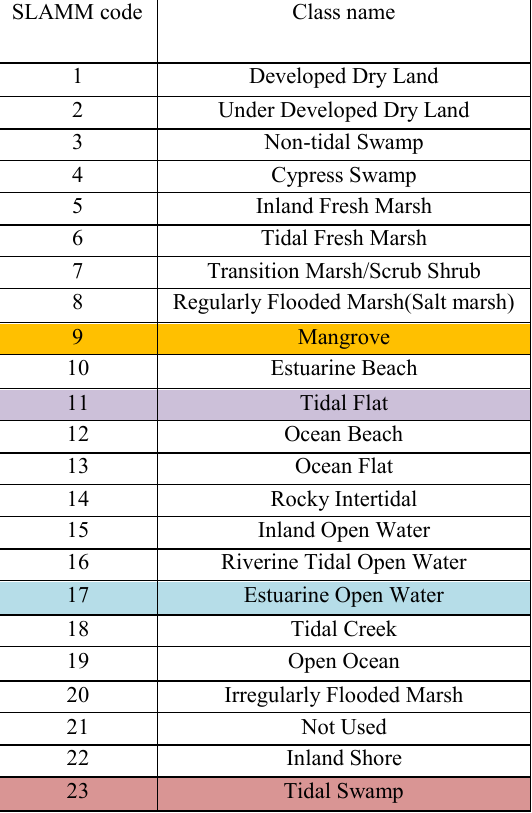
Table1: SLAMM categories/classes according to